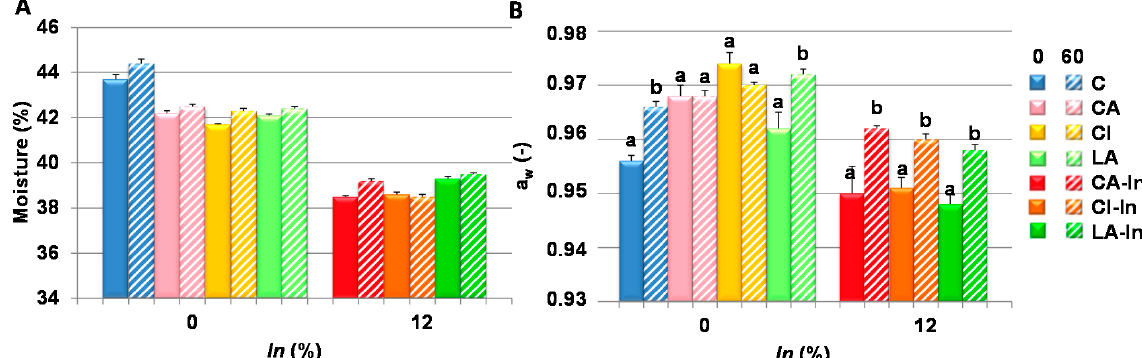
Figure 1. Moisture ( A ) and water activity (a w ) ( B ) of the fresh and stored dough ( − 18 °C-60 days). Different letters indicate significant differences in the same formulation between 0 and 60 days ( p < 0.05). Bars: mean ± standard deviation; (-) unitless parameter.